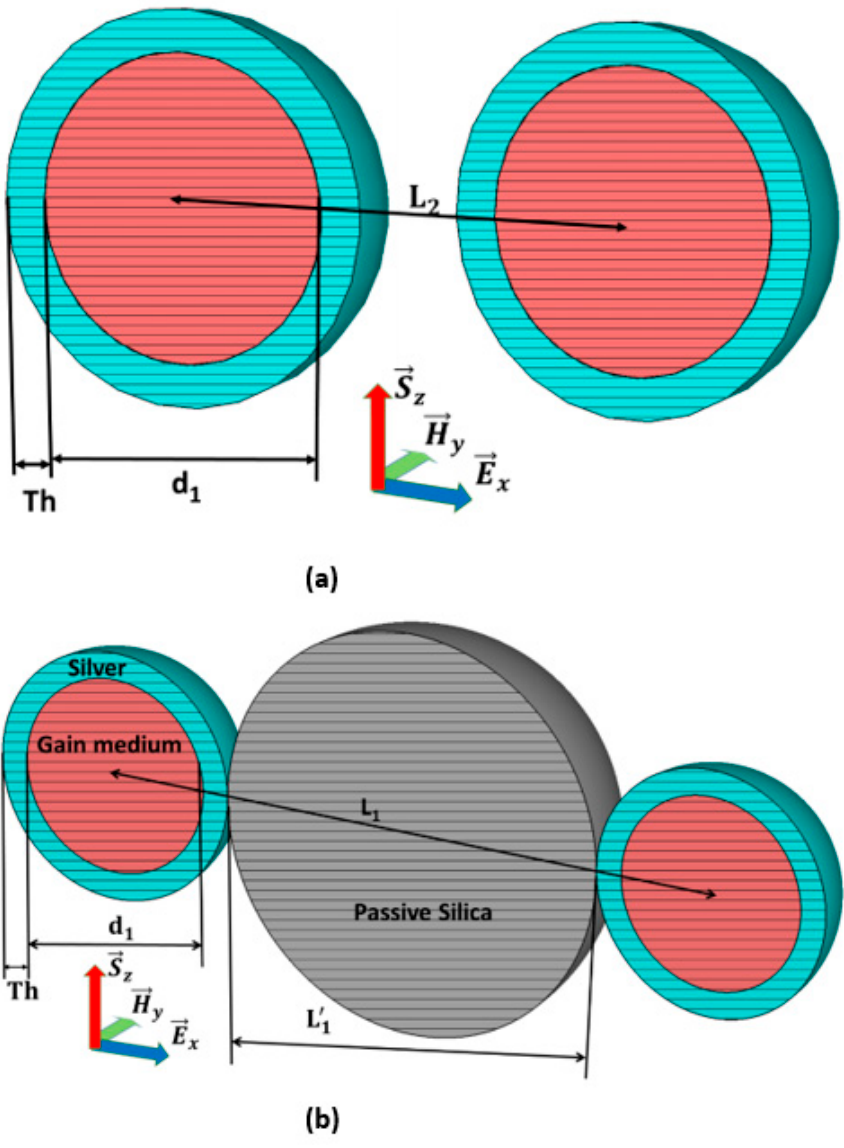
Figure 1. Configurations of dual active coated nanoparticle (CNP) model: ( a ). Two spherical active CNPs constructs’ array configuration-I and ( b ) Array Configuration-II in the presence of passive silica between two